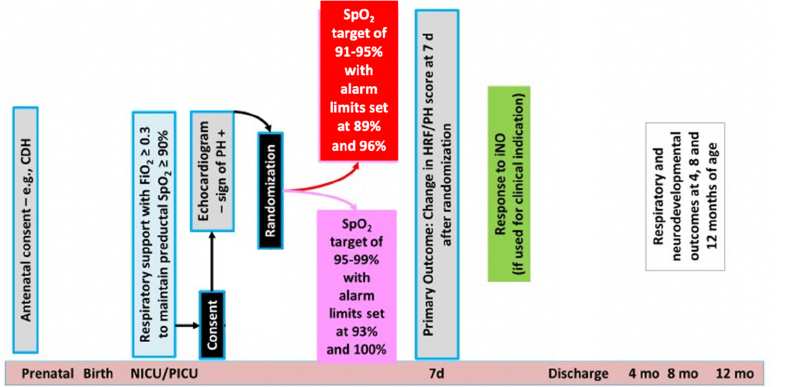
Figure 7. Study events following consent. CDH = congenital diaphragmatic hernia, FiO 2 = fraction inspired oxygen, SpO 2 = oxygen saturation, iNO = inhaled nitric oxide. Copyright Satyan Lakshminrusimha.